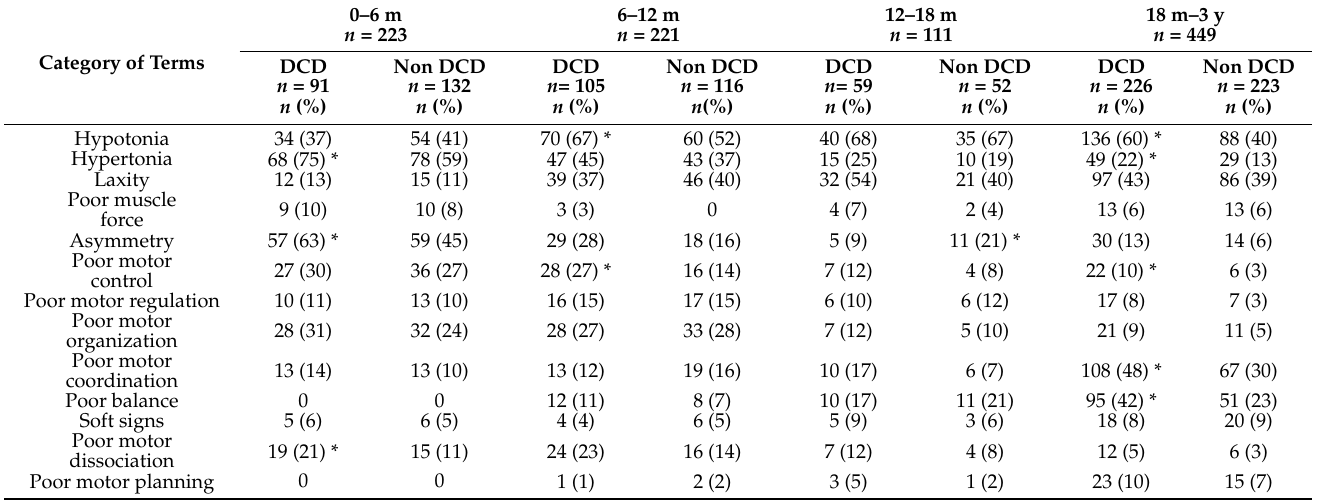
Table 3. Frequency of Categories of Qualitative Descriptions in the Reports of the Children with (at-risk) DCD and without